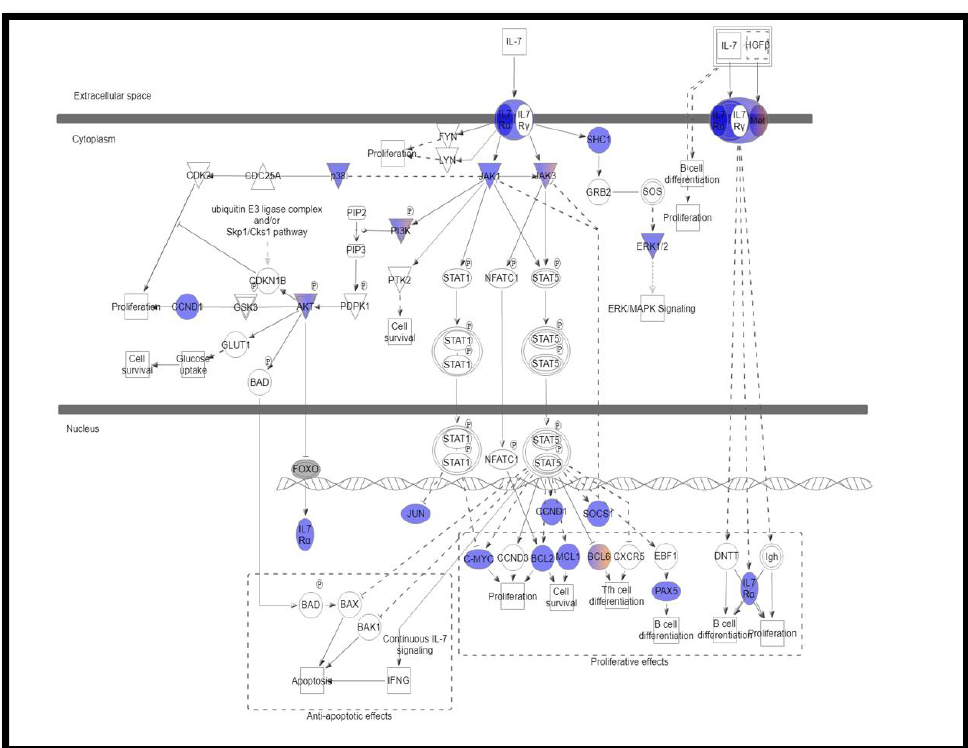
Figure 2. IL-6 signaling pathway identified using ingenuity variant analysis (IVA). Blue represents loss of function, and orange represents gain of function.